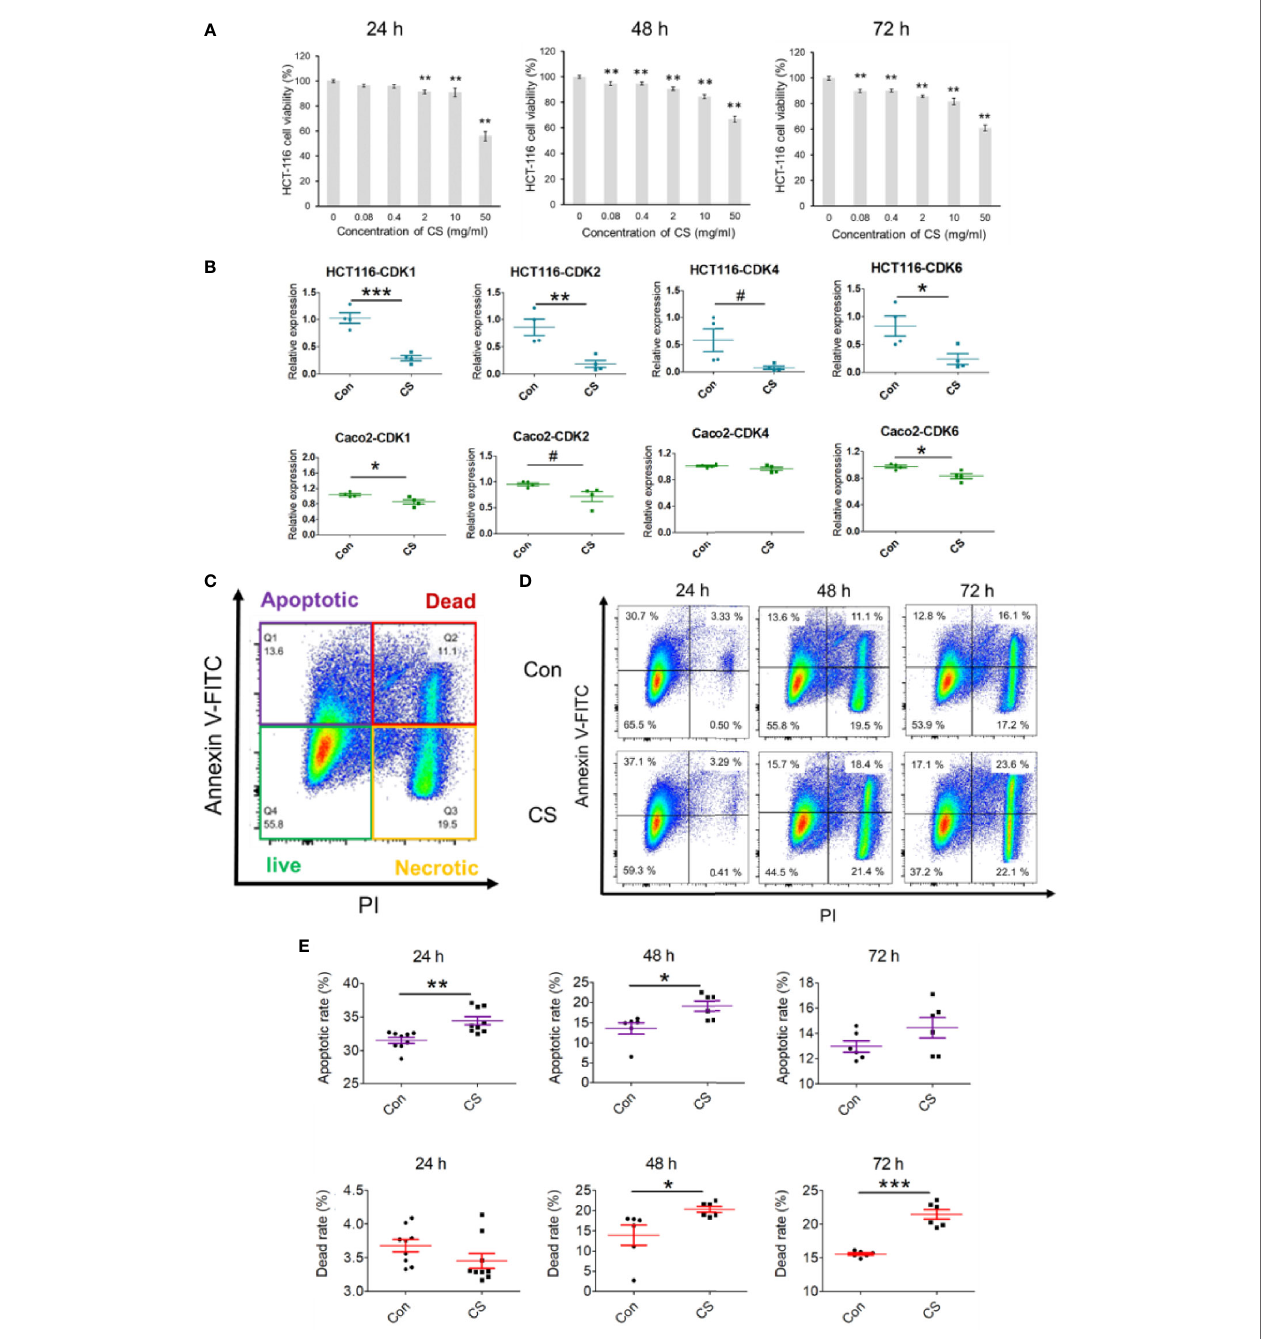
FIGURE 5 | Effects of CS on decreasing the mRNA expression of CDKs and apoptosis in colorectal cancer cell lines. (A) The in fl uence of different concentrations of CS (0, 0.08, 0.4, 2, 10, and 50 mg/ml) on HCT-116 cell viability after 24, 48, and 72 h (n = 4). (B) The effects of CS (0.08 mg/ml) on the mRNA expression levels of CDK1, CDK2, CDK4, and CDK6 after 24 h of culture (n = 4) in HCT-116 cells and Caco-2 cells. (C) Different cell status in the apoptosis assay with fl ow cytometry in HCT-116 cells. (D) Ratios of cell apoptosis and death after culture with CS (24, 48, and 72 h). (E) Histograms of cell apoptosis and death after culture with CS (24, 48, and 72 h, n = 6 – 9). The results are shown as the mean ± SEM. # p < 0.1; * p < 0.05; ** p < 0.01; *** p < 0.001 versus 0 m g/ml CS (Con) assessed using one-way ANOVA followed by Dunnett ’ s multiple comparison for panel (A) , Student ’ s t -test for panels (B, E) The results represent one of two independent experiments with similar